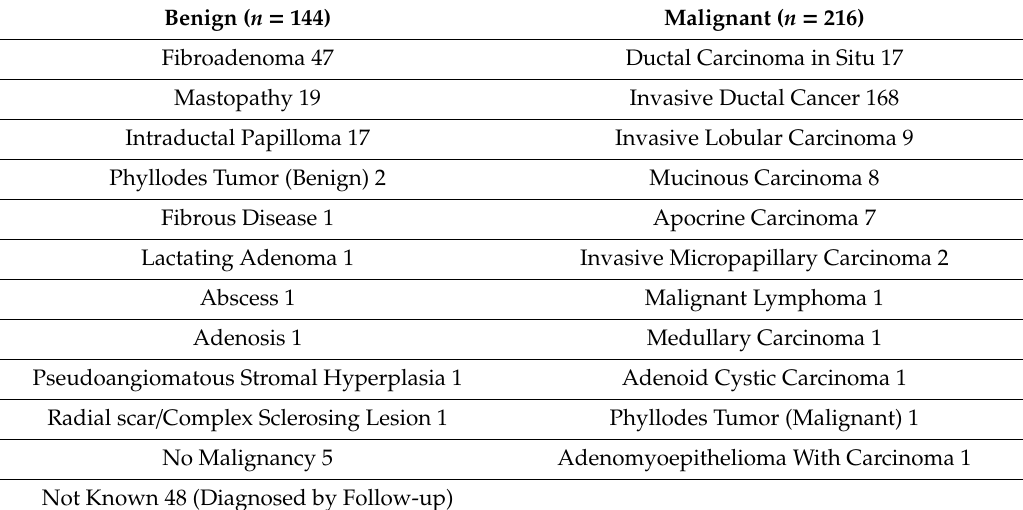
Table 2. Histopathology of